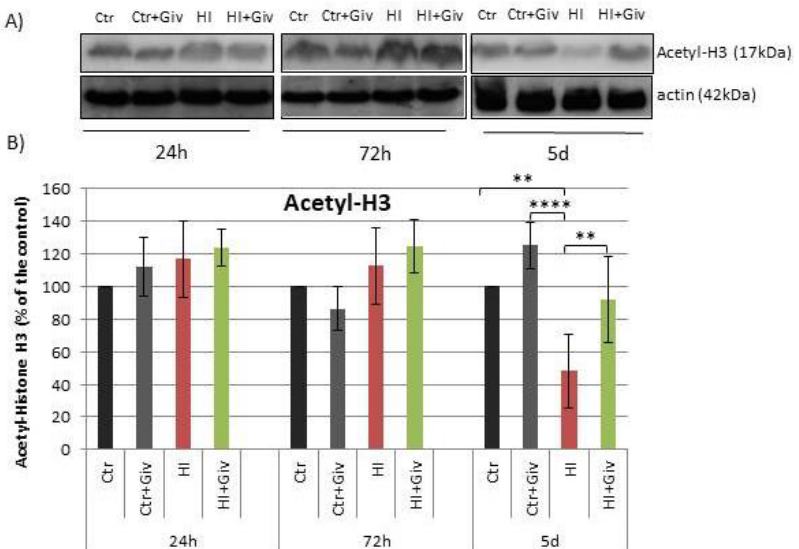
Figure 2. The effect of Givinostat on the acetylation of histone H3 after neonatal hypoxia-ischemia. ( A ) Representative immunoblots of acetylated H3 analyzed 24 h, 72 h and 5 days after HI and in control animals. ( B ) The graph shows the statistical analysis of densitometric data presented as a percent of the control value. The intensity of each band was quantified and normalized in relation to the reference protein (actin). The values are the mean ± SD from five animals per group and time point. Note the decreased level of acetyl-H3 in the hypoxic-ischemic experimental group 5 days after insult. The administration of Givinostat restored the acetylation of H3 to the control level. One-way ANOVA indicated significant differences between the control and HI groups as well as the HI and HI+Giv experimental groups (** p < 0.01) and the Ctr +Giv vs. HI group (**** p < 0.0001).